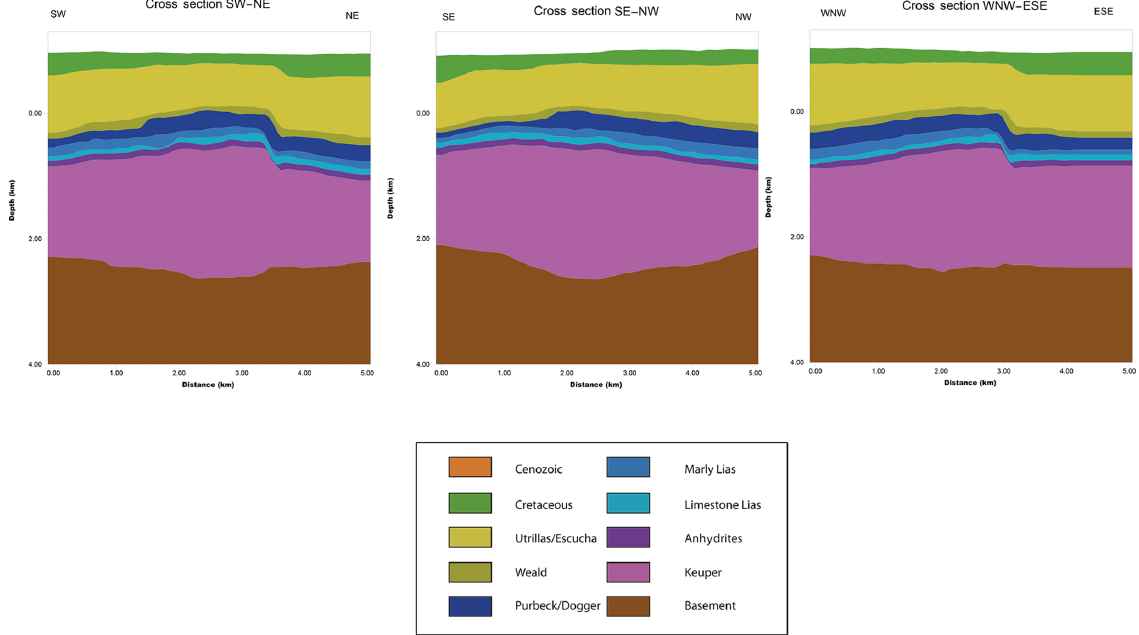
Figure 6. Cross sections extracted from the 3-D gravity inversion model of the basement presented in Fig. 8a (see Fig. 3 for location of the cross